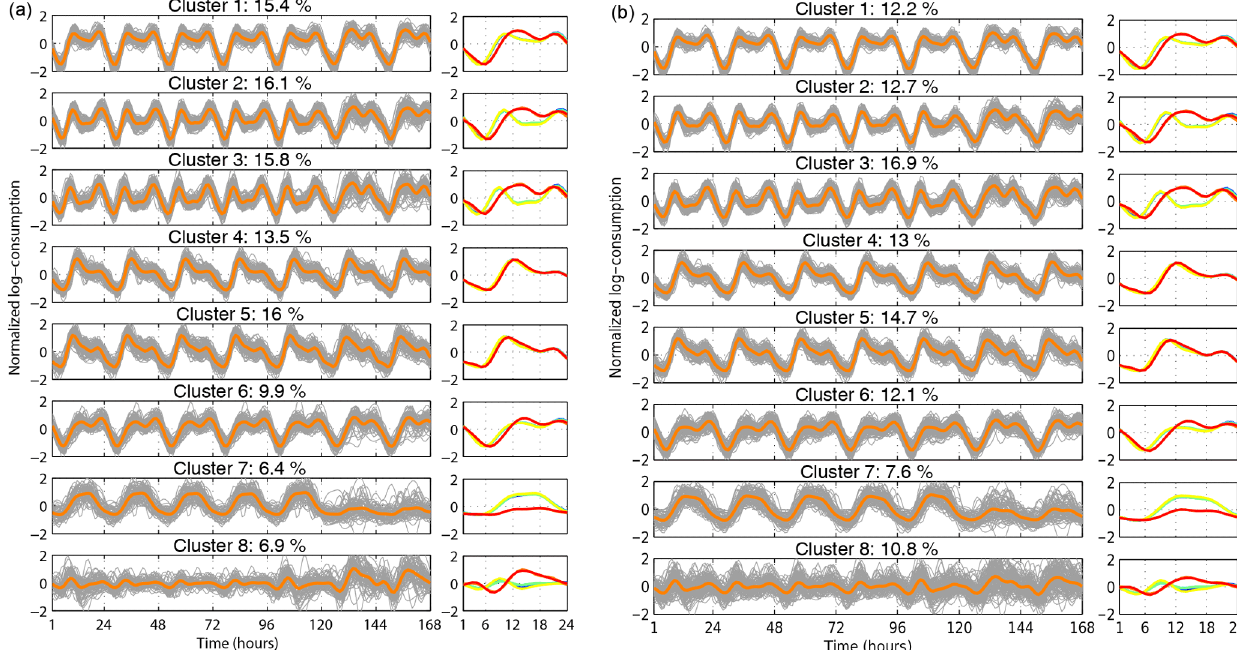
Figure 4. Clustering results obtained with the FPCA-KM (a) and the FReMix (b) . For each side, the subfigures on the left represent a weekly view of the clusters with their prototypes displayed in orange. The subfigures on the right are daily prototypes resulting from the segmentation of the weekly orange curves and colors (from blue to yellow to red) indicate the day of the week (from Monday to